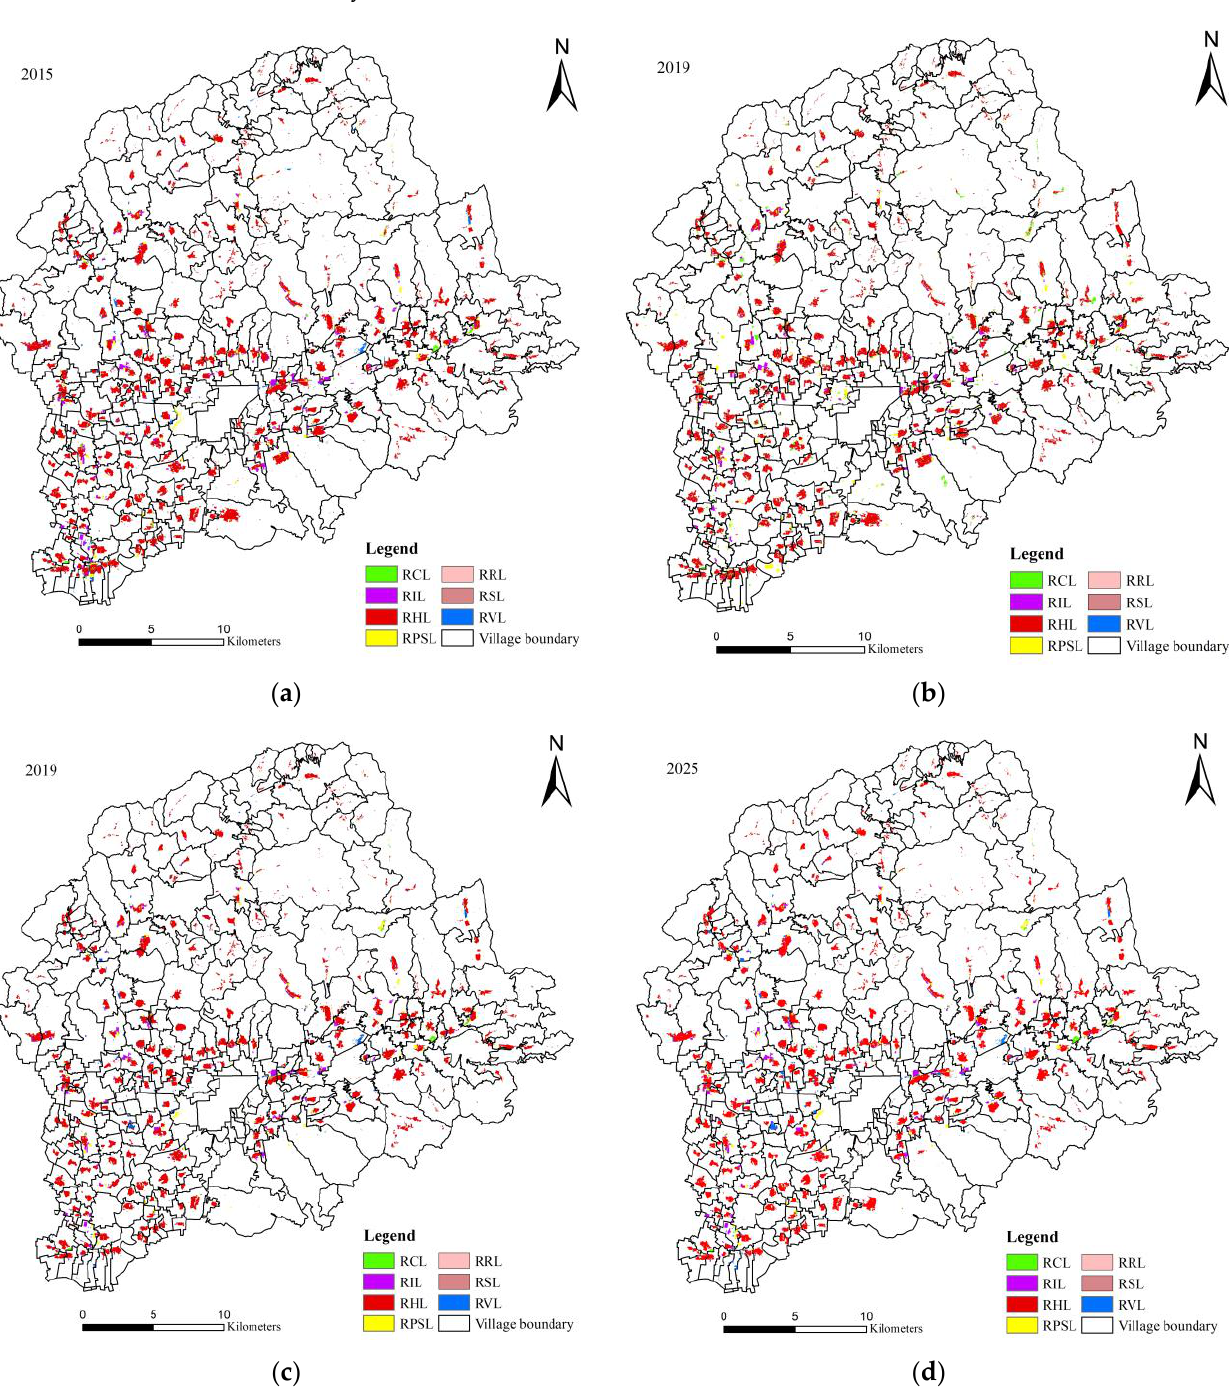
Figure 4. Current situation and simulated distribution of the RSILUS in Pinggu District. ( a ) Present situation of the RSILUS in 2015. ( b ) Present situation of the RSILUS in 2019. ( c ) Simulation situation of the RSILUS in 2019. ( d ) Simulation situation of the RSILUS in 2025. In 2025, the total area of rural settlements in Pinggu District was predicted to be 4431.37 ha, among which the RHL area is the largest, comprising 80.02% of the total,